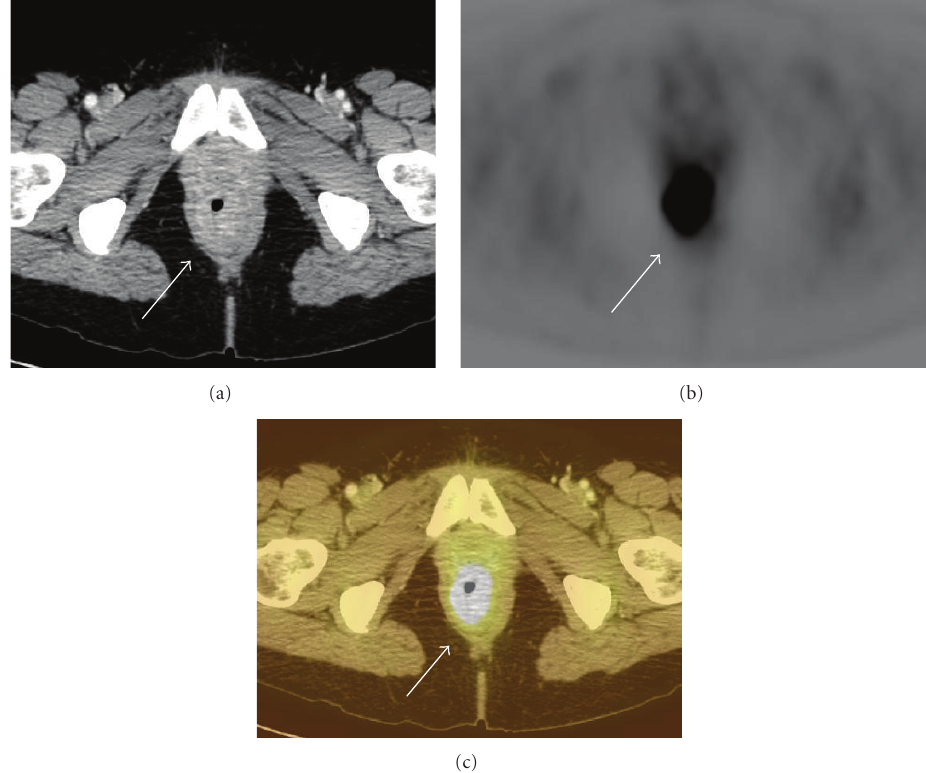
Figure 1: Rectal carcinoma depicted on PET-CT. (a) There is circumferential rectal thickening (arrow) on contrast-enhanced CT. (b) There is avid FDG radiotracer uptake (arrow) on axial FDG-PET. (c) Increased FDG uptake on FDG-PET correlates with thickening (arrow) due to rectal carcinoma seen on CT.